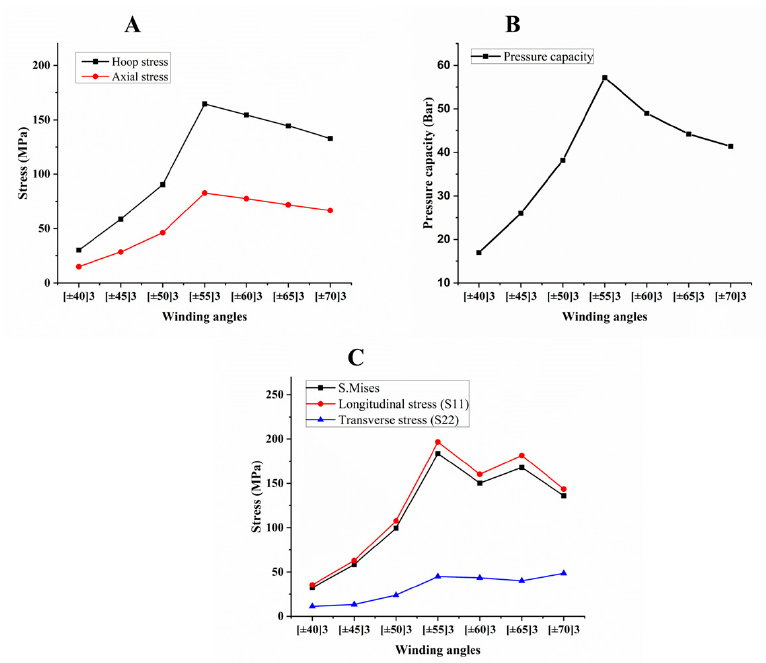
Figure 4. Hoop and axial stress ( A ), pressure capacity ( B ), and various stress ( C ) of composite pipe with different winding angles.